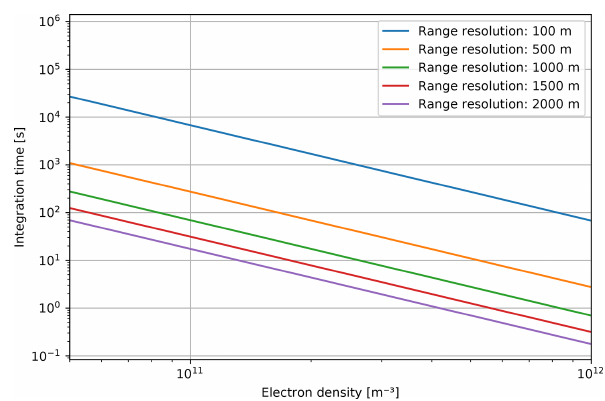
Figure 2. Integration time of targets in the E region observed us- ing the E3D core for transmitting and a single 91 antenna element module for receiving.